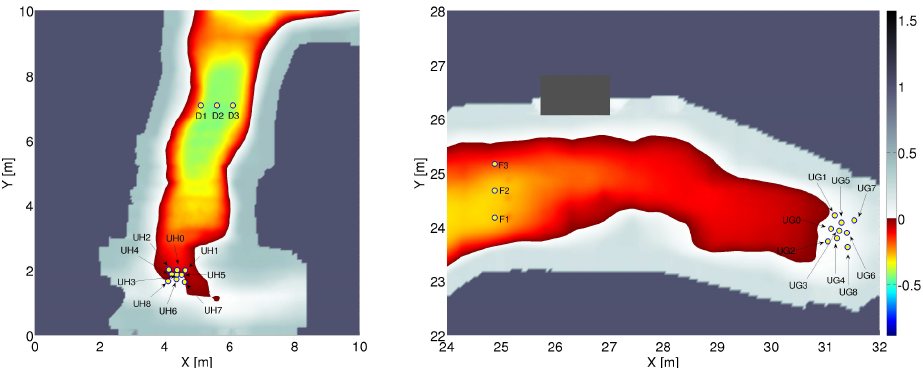
Figure 2. Left panel: location of the time series gauges for run-up computation in Hellesylt. Right panel: location of the time series gauges for run-up computation in Geiranger.